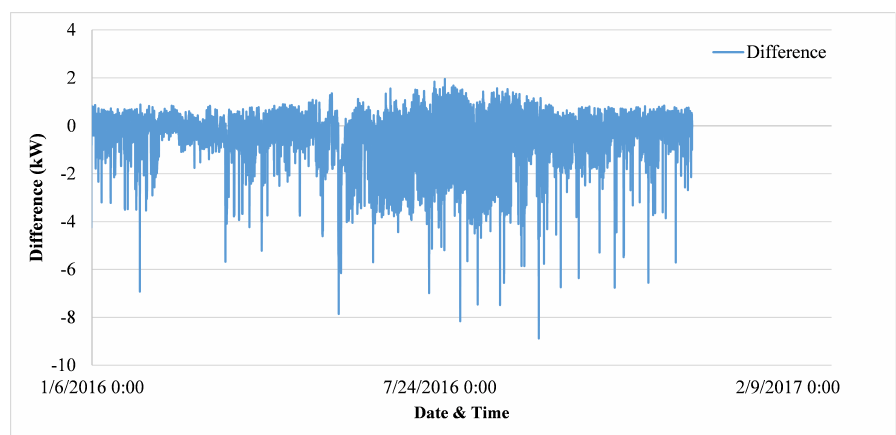
Figure 12. The difference between actual and predicted